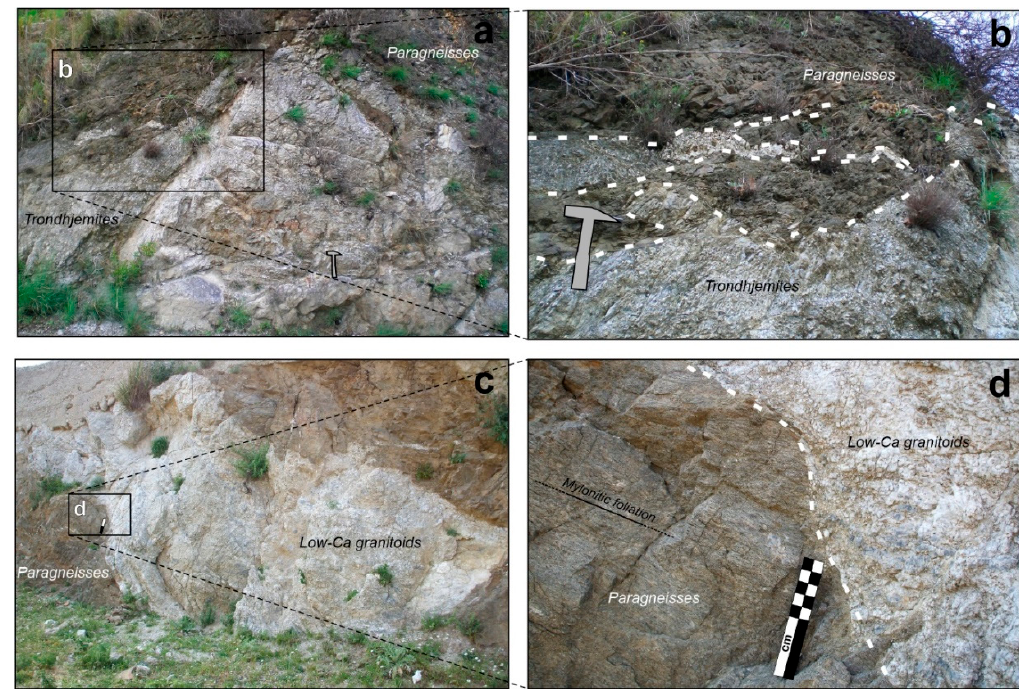
Figure 3. Granitoid-host rock relationships in the Forte Cavalli area. ( a ) intrusive contacts with, in ( b ) detail showing a concordant granitoid offshoot folded together with its host paragneiss; ( c ) intrusive contacts with, in ( d ) detail of migmatitic foliation cut discordantly by the granitoid rock.